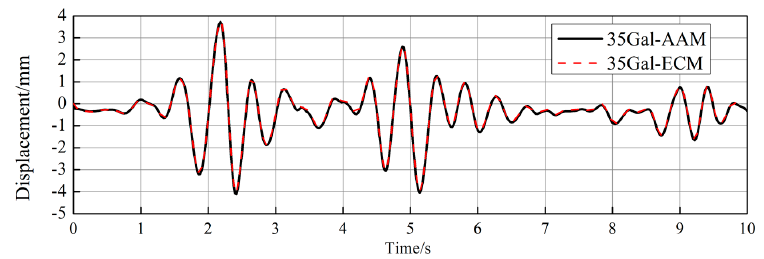
Figure 7. Horizontal displacement on the top of experimental column (35 Gal).